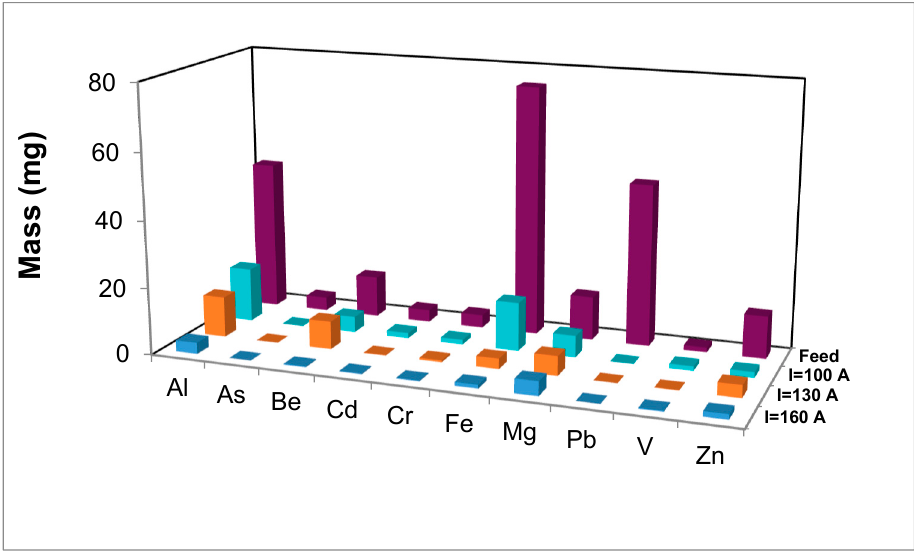
Figure 10. Mass of elements present in phosphate waste before and after treatment and at different plasma currents. Table 4. Concentrations of elements present in the waste at different plasma currents obtained by ICP.